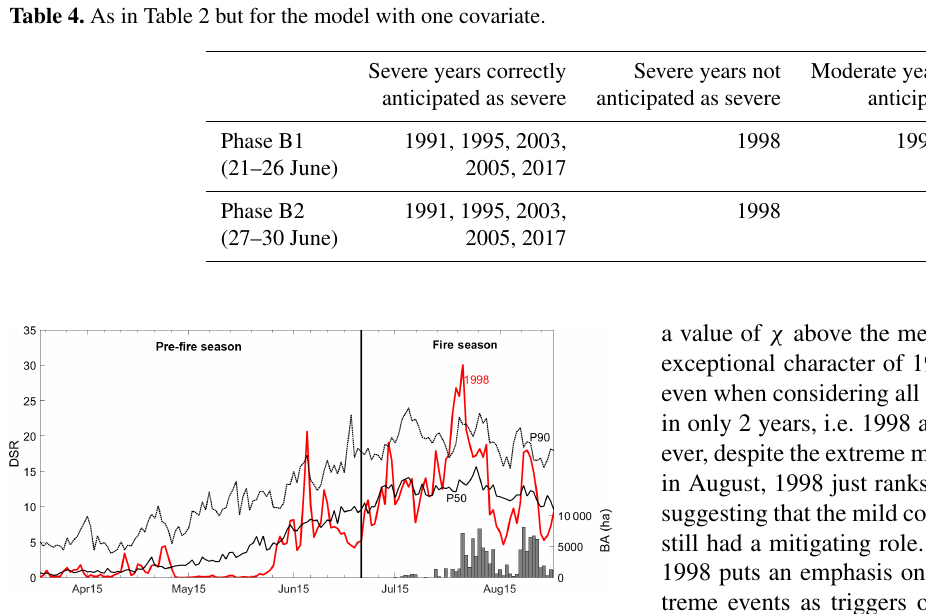
Figure 10. Temporal evolution of daily values of DSR for 1998 (red curve) and of the daily values of the median (solid black curve) and of percentile 90 (dotted black curve) for the period 1980–2018. The dark grey bars indicate the cumulated daily values of BA (in hectares) for Portugal. The vertical black line subdivides the period into pre-fire and fire